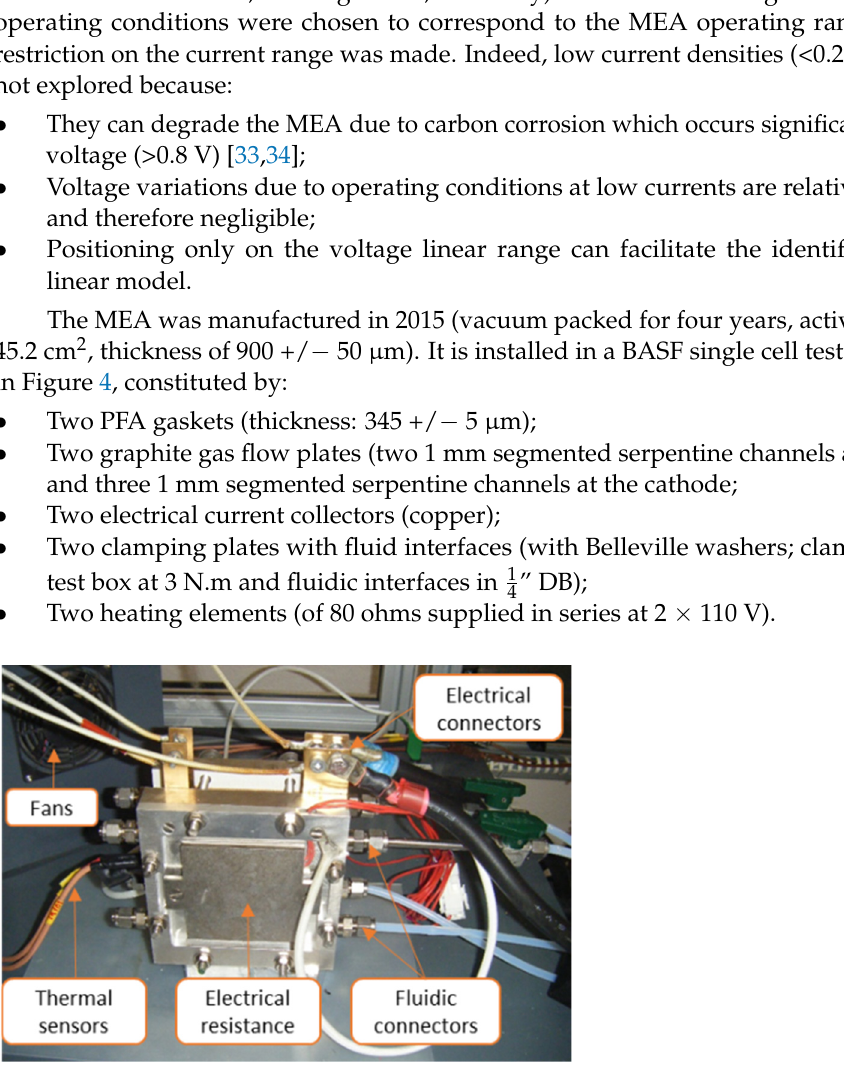
Figure 4. Photography of the HT-PEMFC test box in the in-house test bench.